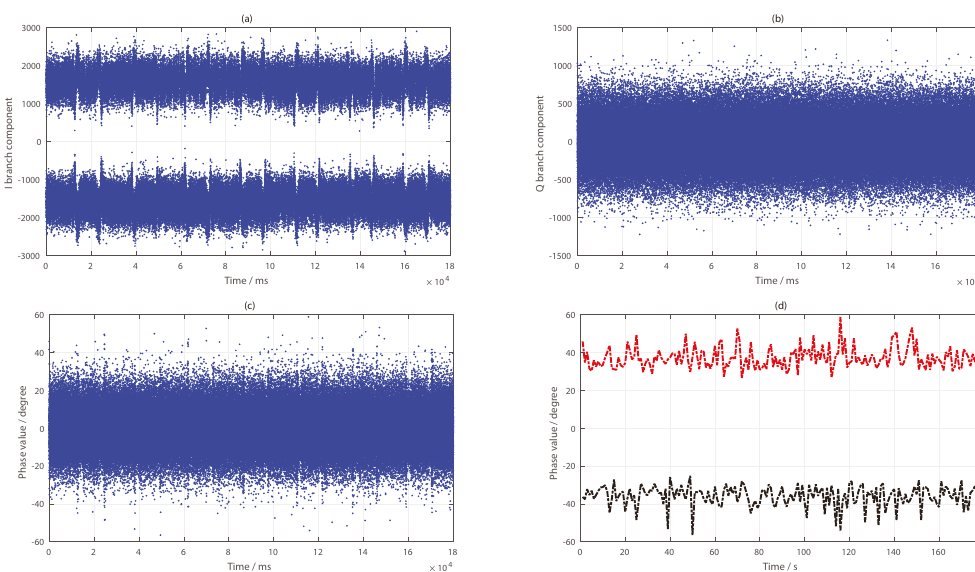
Figure 17. Results for the BeiDou PRN2 satellite reflected signal: ( a ) I branch component data; ( b ) Q branch component data; ( c ) phase difference information (in ms); ( d ) phase difference information (in